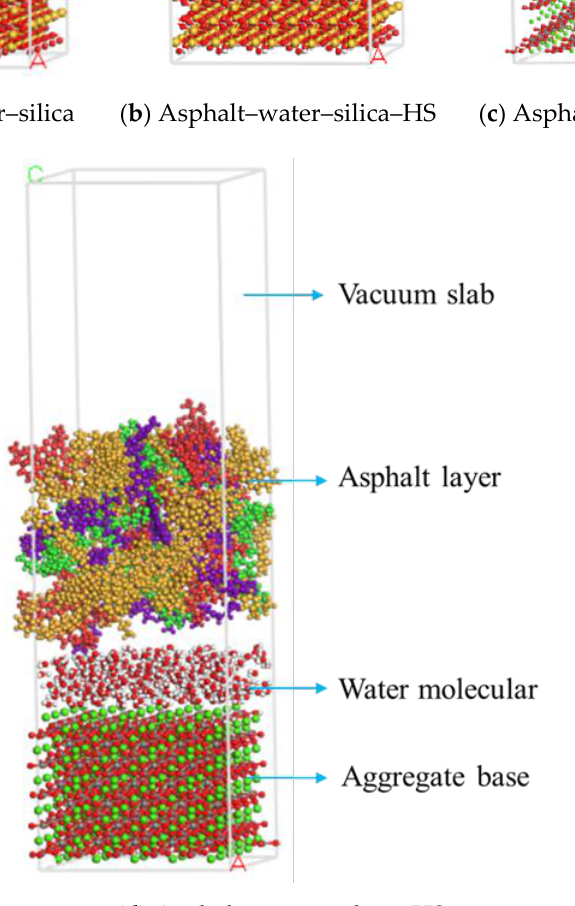
Figure 5. Asphalt–water–aggregate interface model (for asphalt layer, asphaltene: red, resin: purple, saturate: green, aromatic: yellow; for water molecular and aggregate base, carbon: grey, calcium: green, oxygen: red, silica: orange, hydrogen: white).